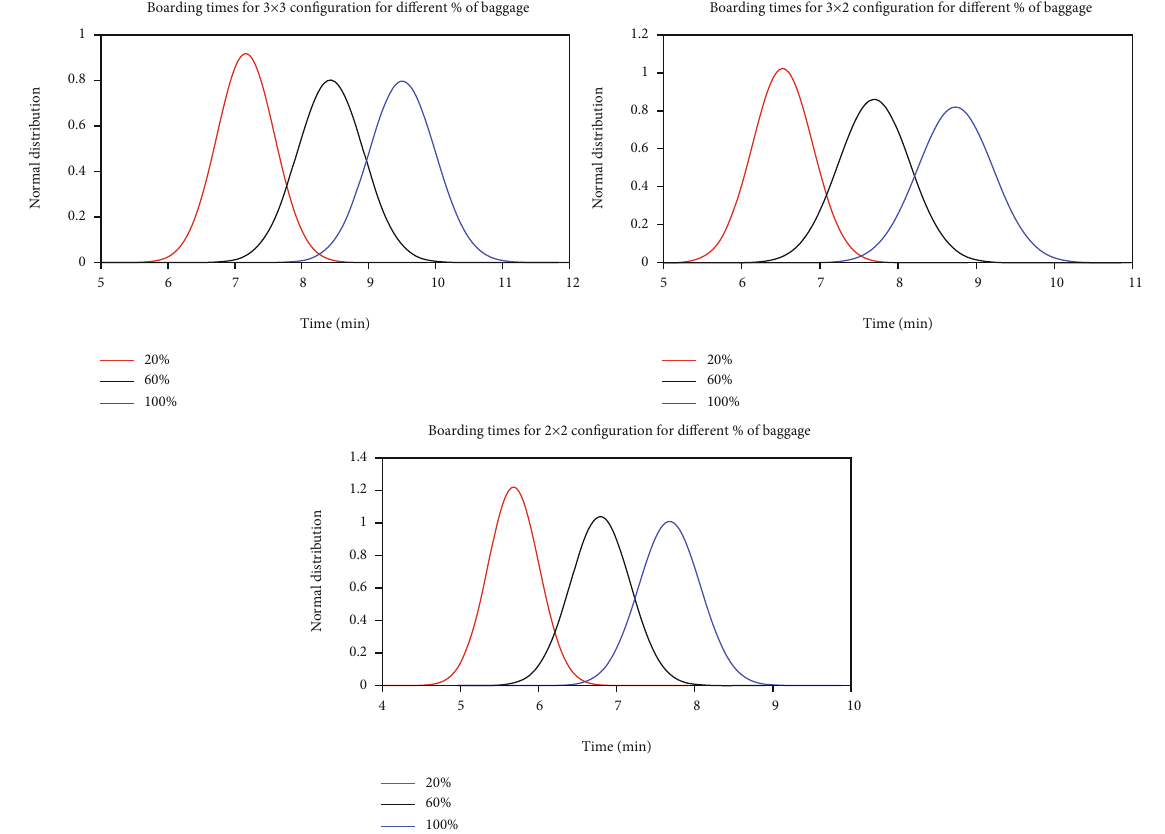
Figure 11: Fitted normal distribution curves for the three aircraft con fi gurations using the random boarding strategy for di ff erent % of baggage.